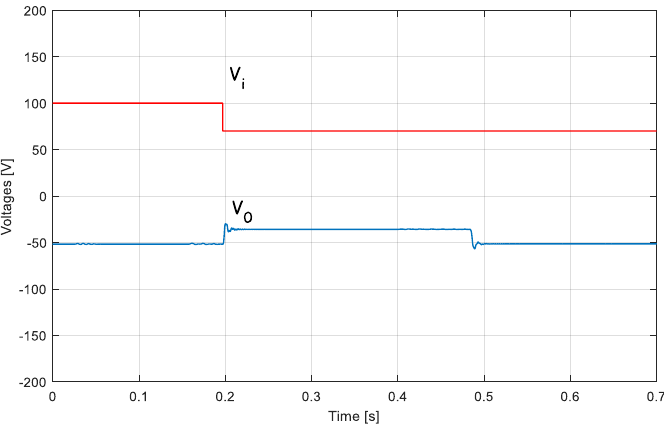
Figure 13. Simulation results of the input and inverted output voltage in transient mode.